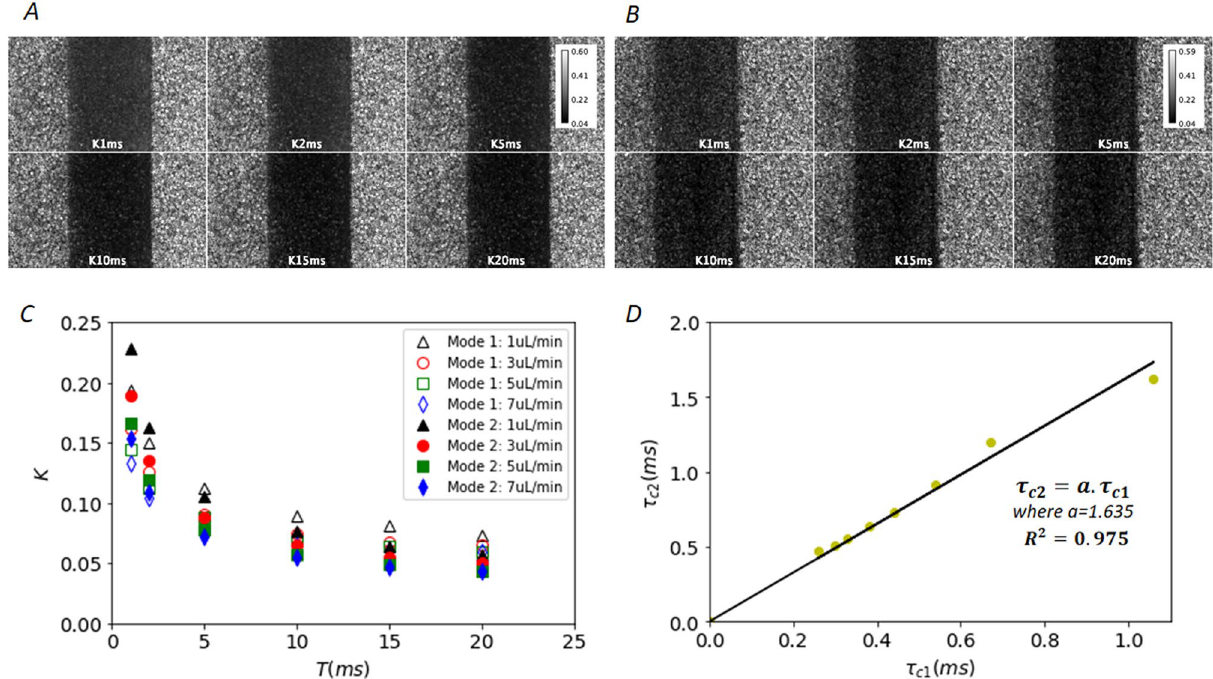
Figure 5. Comparison between mode 1 (laser modulated method) and mode 2 (synthetic exposure). (A) Speckle contrast images of intralipid-2% flowing at 3 µl/min in a 300 µm diameter channel for 6 exposure times (mode 1). (B) Same as (A) for mode 2. (C) Speckle contrast in both modes for intralipid-2% flowing at 1, 3, 5 and 7 µl min –1 in a 300 µm diameter channel versus exposure time (1, 2, 5, 10, 15 and 20 ms). Open symbols correspond to mode 1, filled symbols correspond to mode 2. (D) Decorrelation times for mode 2 data ( τ c 2 ) as a function of those derived from mode 1 data ( τ c 1 ) for all flows ranging from 1 to 8 µl min −1